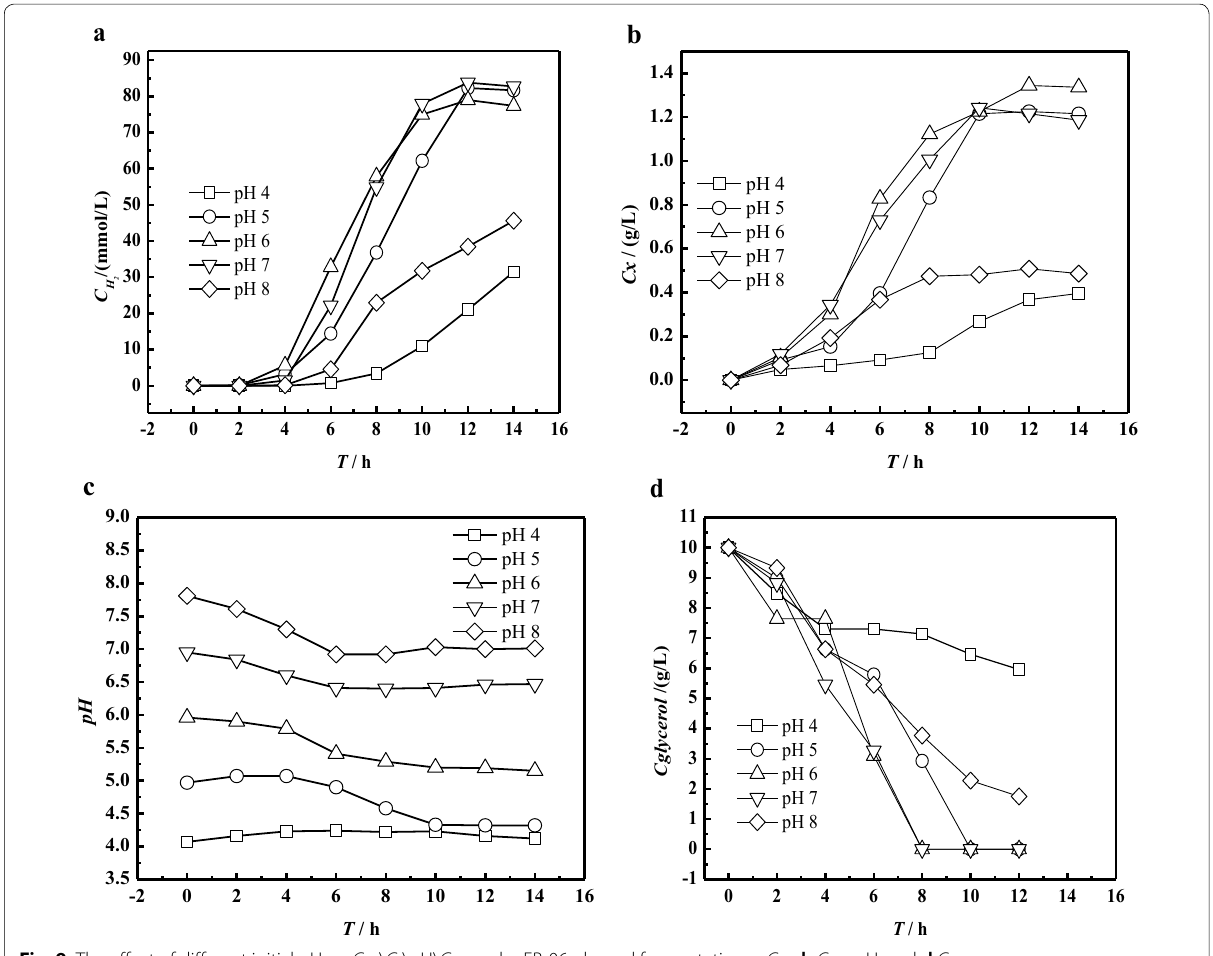
Fig. 9 The effect of different initial pH on C H2 \ C x \pH\ C glycerol by EB-06 glycerol fermentation. a C H2 , b C x , c pH, and d C glycerol